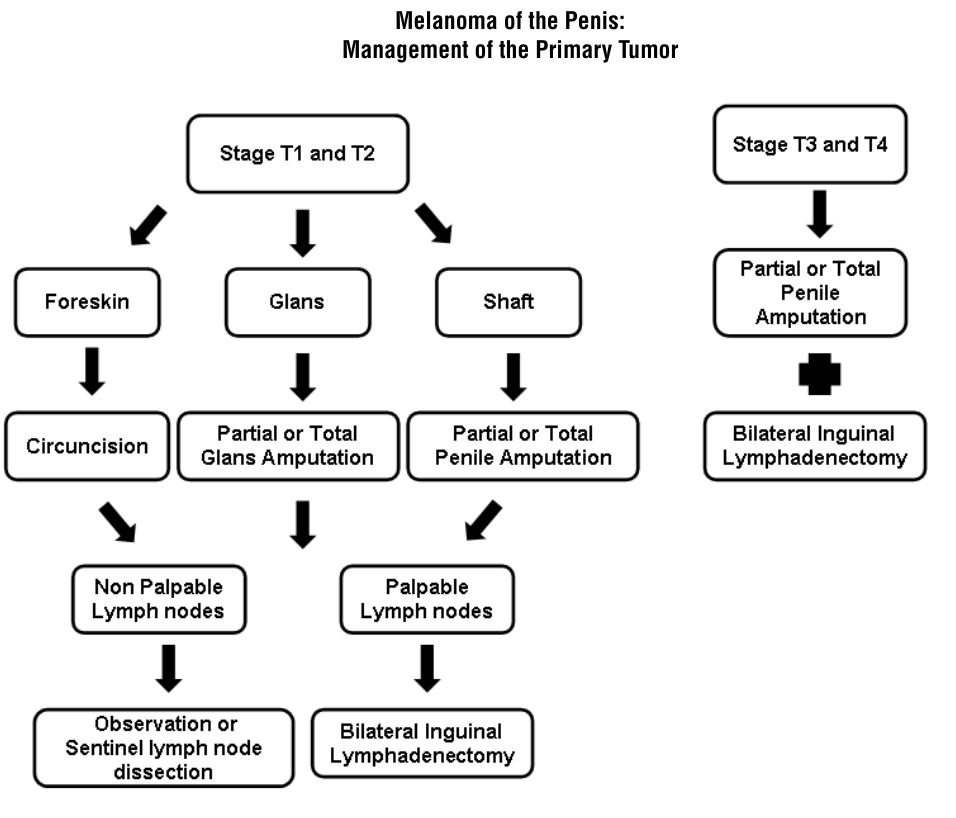
Figure 3 - An algorithm showing our treatment for patients with melanoma of penis.